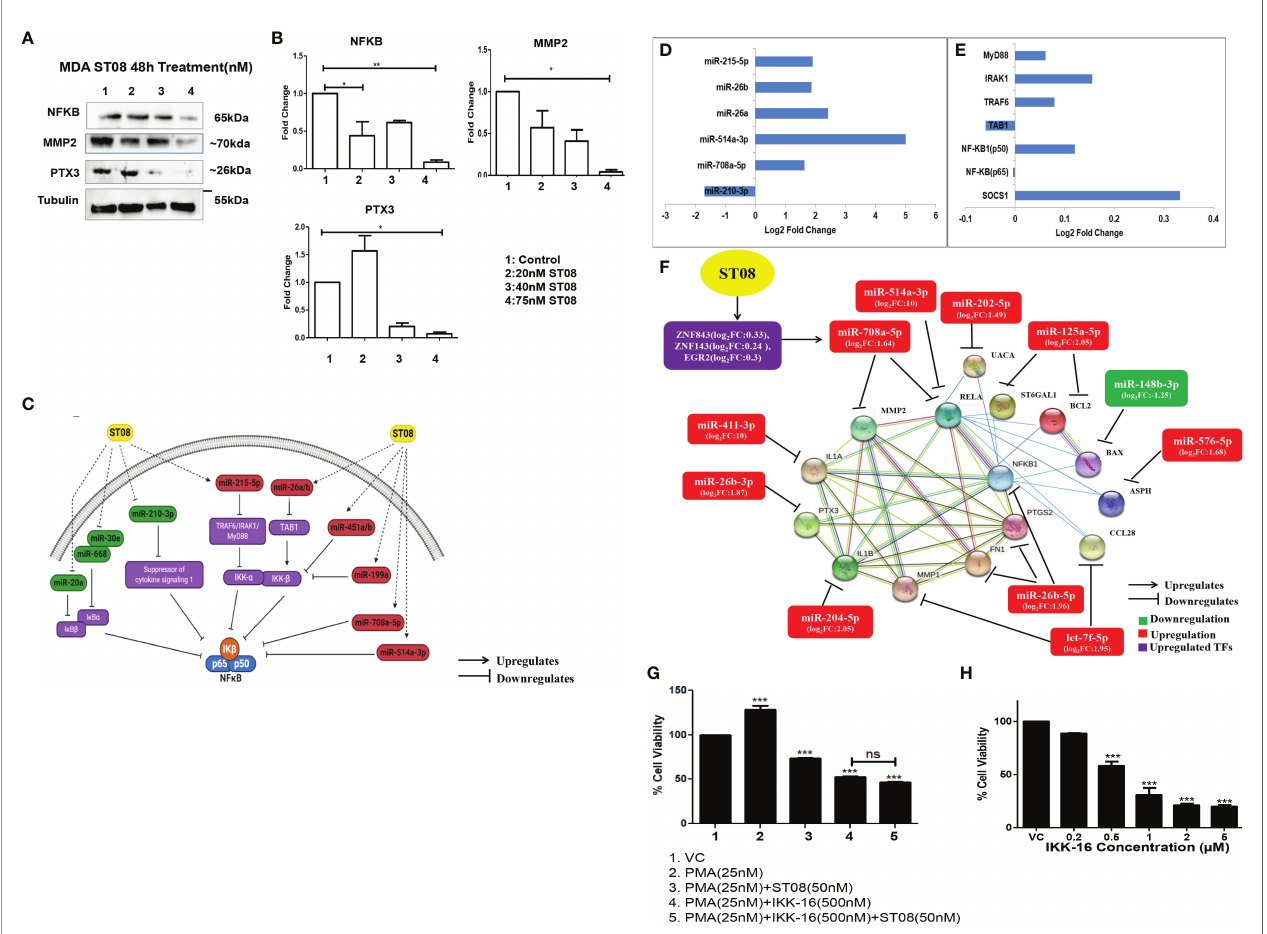
FIGURE 7 | NF- k Bregulation in MDA-MB-231 cells upon ST08 treatment: (A) Western blot analysis NF- k B protein and its targets was done on ST08 treated MDA- MB-231 cell lysates. Each experiment was done in duplicates, and a representative image is shown for each marker. Quanti fi cation was done for each marker (B) and is represented as a bar graph of mean +/- SEM. One sample t-test and one way ANOVA test was performed, and the p-value was calculated between control, and ST08 treated groups (*: p -value <0.05, **: p -value <0.005). (C) ST08 induced upregulation of miRs like miR-215-5p,miR-26a/b,miR-451a/b,miR-199a,miR- 708a-5p and miR-514a-3p which directly or indirectly inhibited NF- k B. Whereas miRs like miR-20a, miR-668, miR-30e, miR-210-3p were downregulated, which upregulated IKB, SOCS1, and indirectly downregulated NF- k B.Bar graph depicting log2 Fold change of miRNA (D) and mRNA (E) involved in NF- k B pathway. (F) miRNA-mRNA regulatory network of NF- k B pathway upon ST08 treatment in MDA-MB-231 cells. ST08 regulates TFs like ZNF843, ZNF143, and EGF3 to regulate the expression of miR-708a-5p. miR-708a-5p,miR-514a-3p regulates NF- k B. ST08 also regulates expression of other miRs like miR-411-3p,miR-26b-3p/ 5p, miR-205-5p,let-7f-5p, miR-576-5p, miR-148b-3p,miR-125a-5p and miR-202-5p. These miRs regulate the expression of their targets, as shown in the network. (G) Effect of ST08 and IKK-16 on PMA-induced proliferation in MDA-MB-231 cells as tested by LDH assay. (H) Bar graph depicting cell viability upon IKK-16 treatment for 48h on MDA-MB-231 breast cancer cell line as tested by LDH assay. Experiments were performed a minimum of three times, and the bar graph shows mean ± SEM. One-way ANOVA test was performed and p-value was calculated between control and treated groups (*p < 0.05, **p < 0.005, ***p < 0.0001, ns, not signi fi ( Supplementary Figure 7) . One of the known translation regulators is miRNA. To identify miRs against NF- k B, we utilized TargetScan (75). We identi fi ed several miRNAs against the NF- k B pathway, differentially expressed in ST08 treated samples. One of the miRs, miR-708a-5p, was signi fi cantly upregulated and may regulate NF- k B. We also obtained differentially expressed transcription factors that can bind to the promoter of the miRNA and regulate gene expression. We found that TFs like ZNF843, ZNF143, EGR2 were upregulated ( Figure 7F ), and they most probably regulated miR-708- 5p expression.